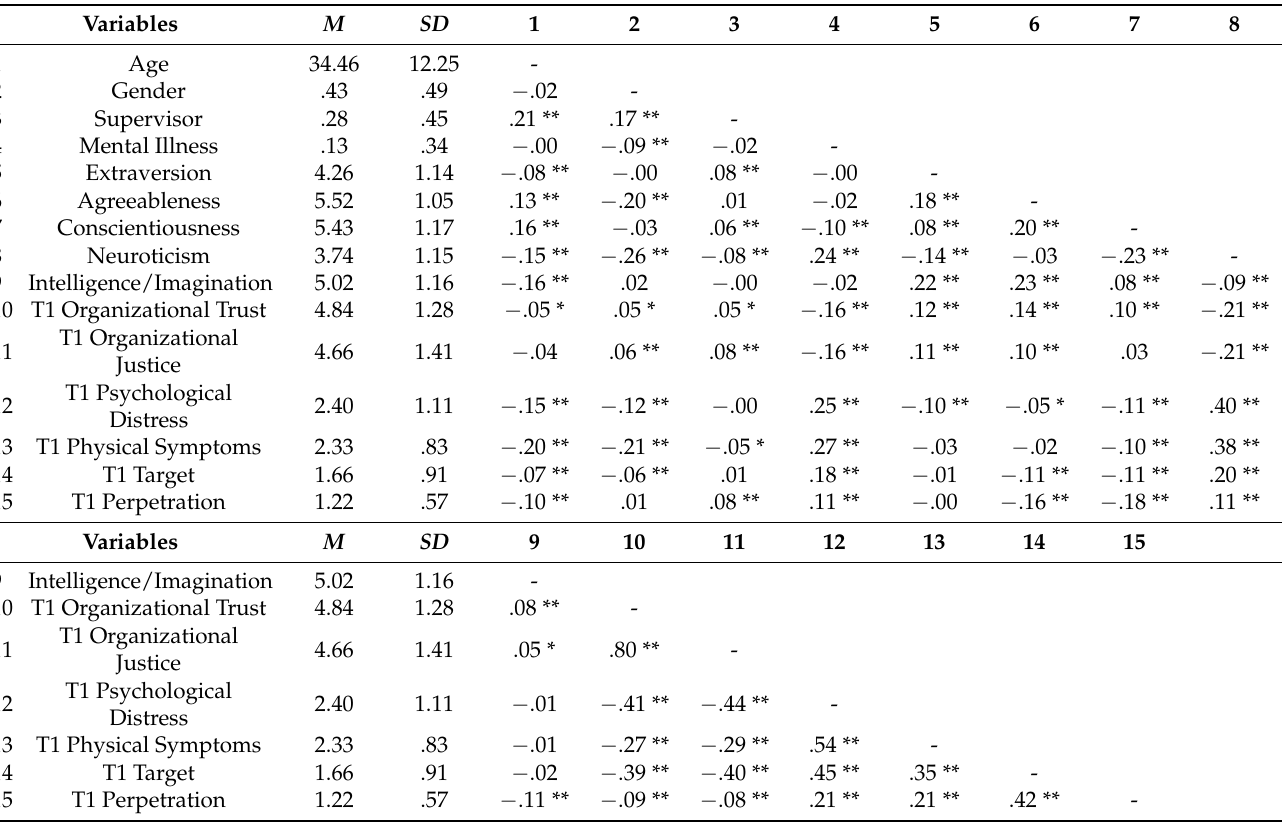
Table 2. Correlations of main variables in the longitudinal study